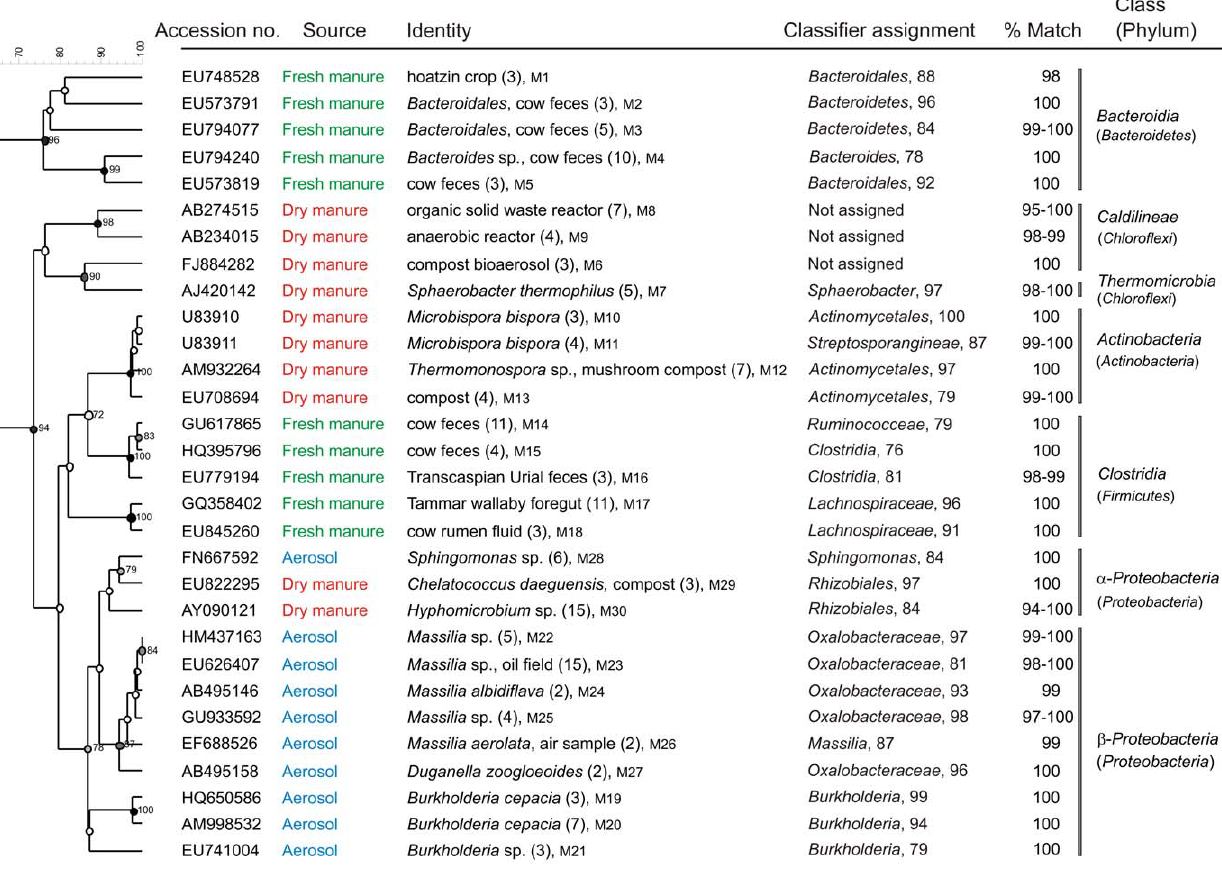
Figure 3. Phylogenetic relationship of 10 abundant 16S rRNA sequences from aerosol and manure samples from the Modesto dairy. Identity or the original source of uncultured bacteria and the accession numbers are given. Numbers in parenthesis following the source are number of clones characterized for the sequence. Numbers following the clones are identifiers for submission to GenBank and sequence numbers M1 to M30 correspond with GenBank accession numbers HQ340034 to HQ340063. Bootstrap values . 70% are noted at each node. Numbers following the Classifier assignment to the hierarchial taxa are percent reliability values for the classification.